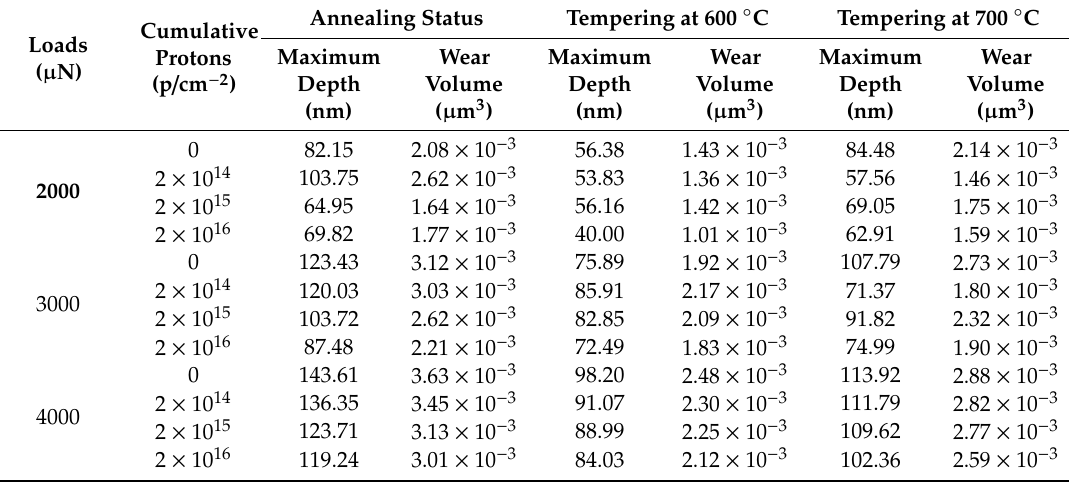
Table 5. The wear depth and wear volume of AISI 420 stainless steel after proton radiation with di ff erent cumulative